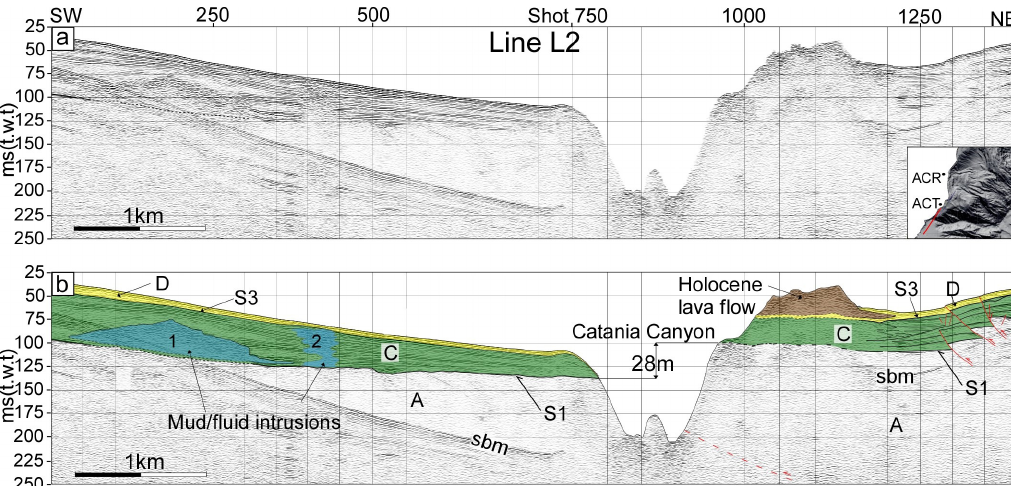
Figure 4. ( a ) Un-interpreted; and ( b ) interpreted line L2 showing reverse faulting, extending from the seafloor into the basement Unit A (see Figure 1b for location). Along the SW sector, Pleistocene-Holocene sediments are tilted toward the Catania Canyon, with a displacement of ~28 m. Mud/fluid intrusions (1 and 2), deforming the units C and D, are evident. Red dashed line: inferred thrust fault. ACR: Acireale; ACT: Aci Trezza; S1 and S3, erosional surfaces; sbm, sea bottom multiple (A, B, C, D: see Figure 2 for other